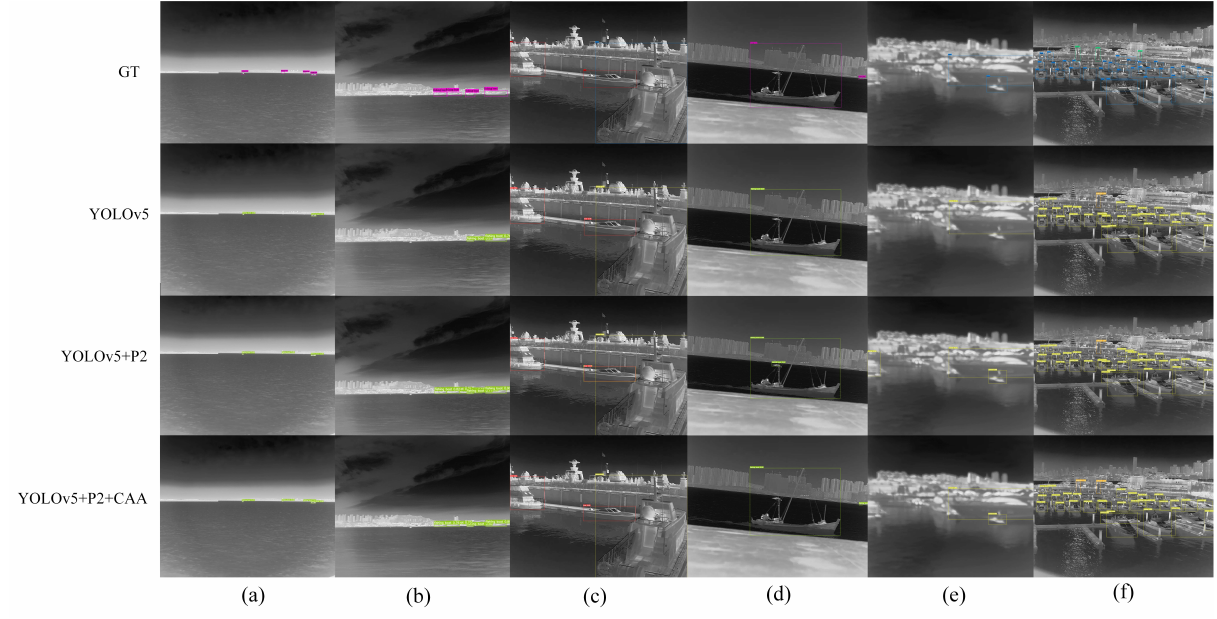
Figure 12. The infrared ship detection results of different methods. GT represents the ground truth box, YOLOv5 represents the original baseline network model, YOLOv5+P2 represents the addition of high resolution feature layer P2 based on YOLOv5, YOLOv5+P2+CAA represents the addition of P2 and the CAA feature fusion module based on YOLOv5 and ( a – f ) represents the 6 groups of detection results obtained by using different